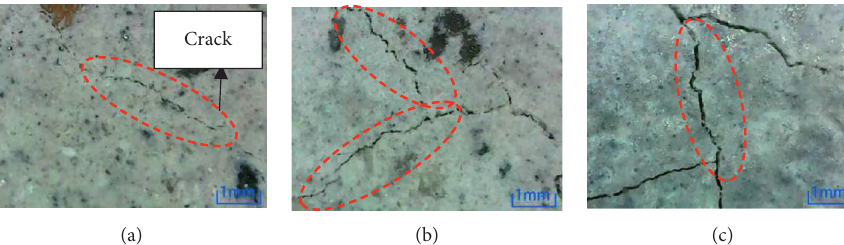
Figure 30: Microscopic observation of specimen soaked in NaOH solution at position 1. (a) 0%. (b) 1%. (c) 2%.